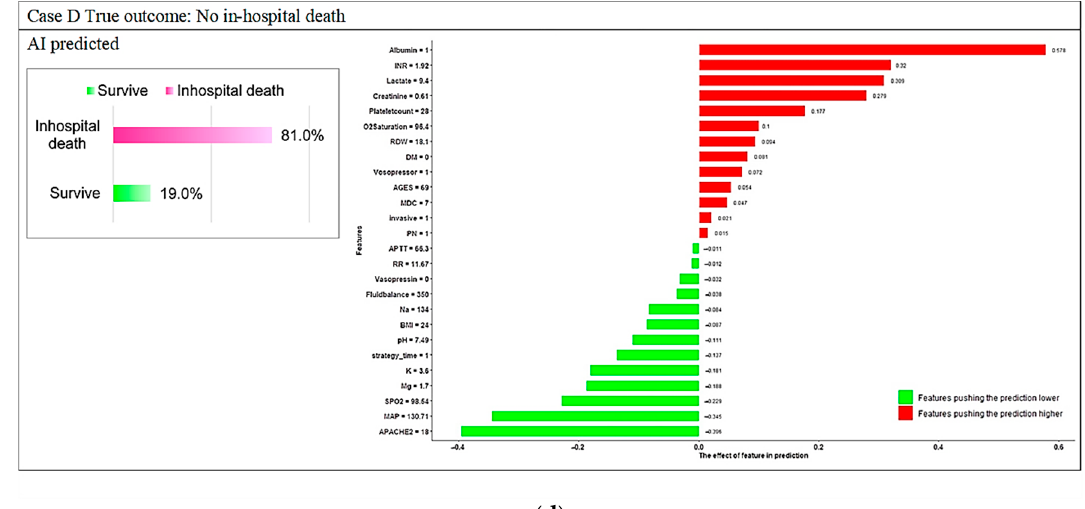
Figure A2. Local explanation plots for individuals with various in-hospital mortality statuses and GBM model predictions. ( a ) In-hospital death and AI predicted in-hospital death; ( b ) non-in-hospital death and AI predicted non-in-hospital death; ( c ) in-hospital death but AI predicted non-in-hospital death; ( d ) non-in-hospital death but AI predicted in-hospital death.